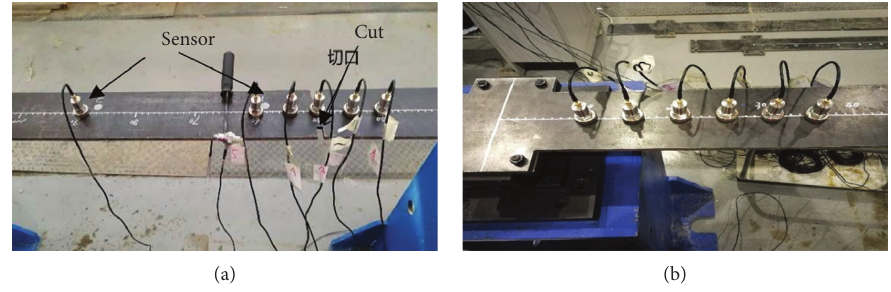
Figure 27: Simply supported beam sensors layout.